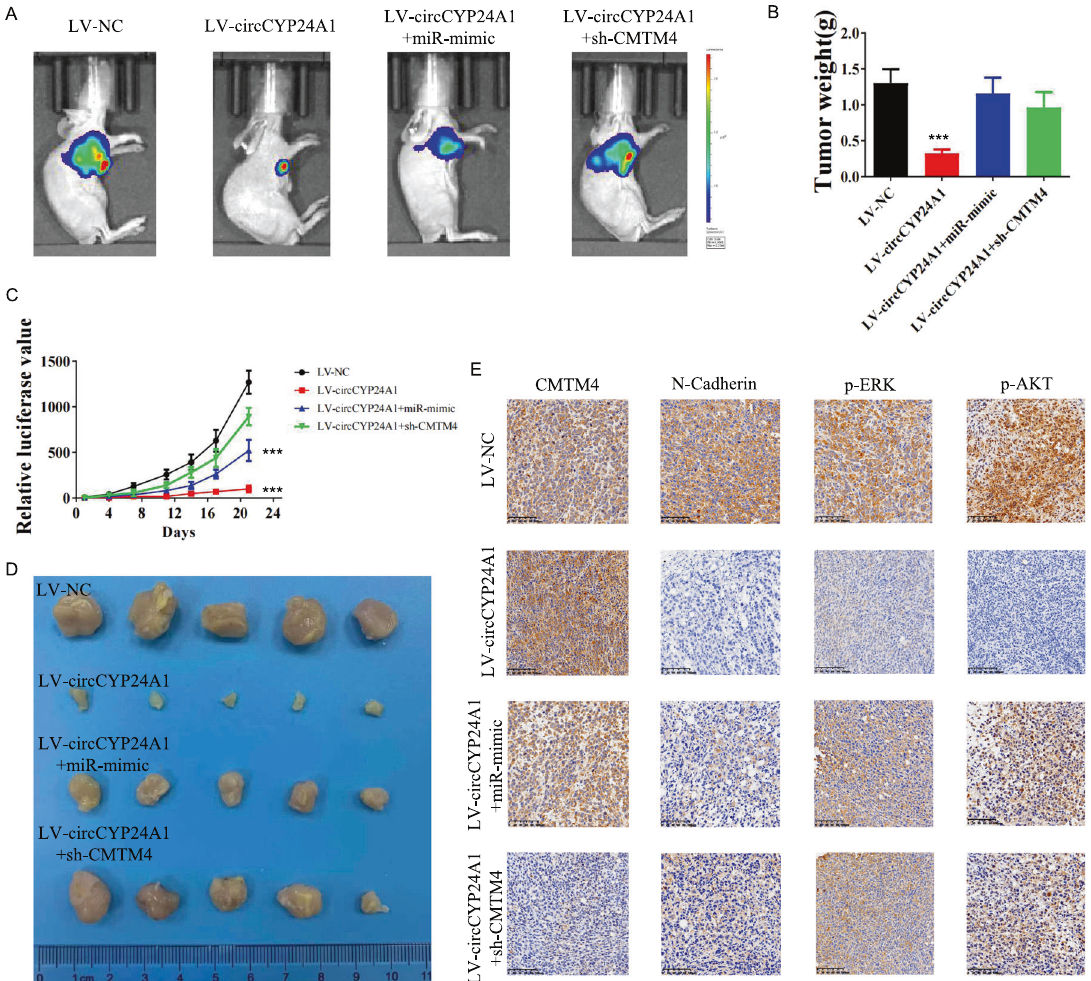
Fig. 7 Overexpression of circCYP24A1 suppresses RCC progression in vivo. Luciferase-expressing 786-O cells transfected with LV-NC, LV- circCYP24A1, LV-cirCYP24A1 + miR-421 mimic, and LV-circCYP24A1 + sh-CMTM4 were used to establish subcutaneous xenograft models ( N =